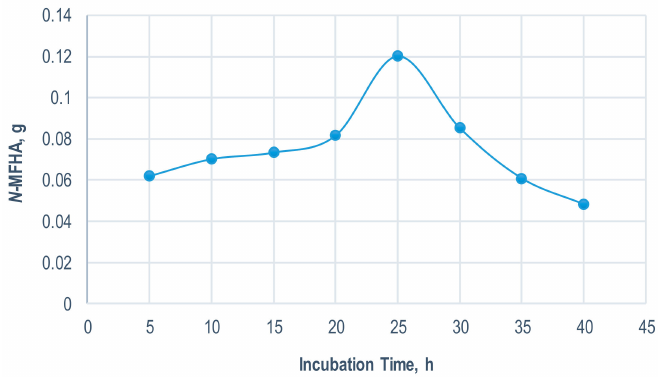
Figure 2. E ff ect of incubation time: 2 g of oil, 10 mmol of N-methylhydroxylamine, 15 mL of hexane, 0.02 g of Lipozyme TL IM, and 40 ◦